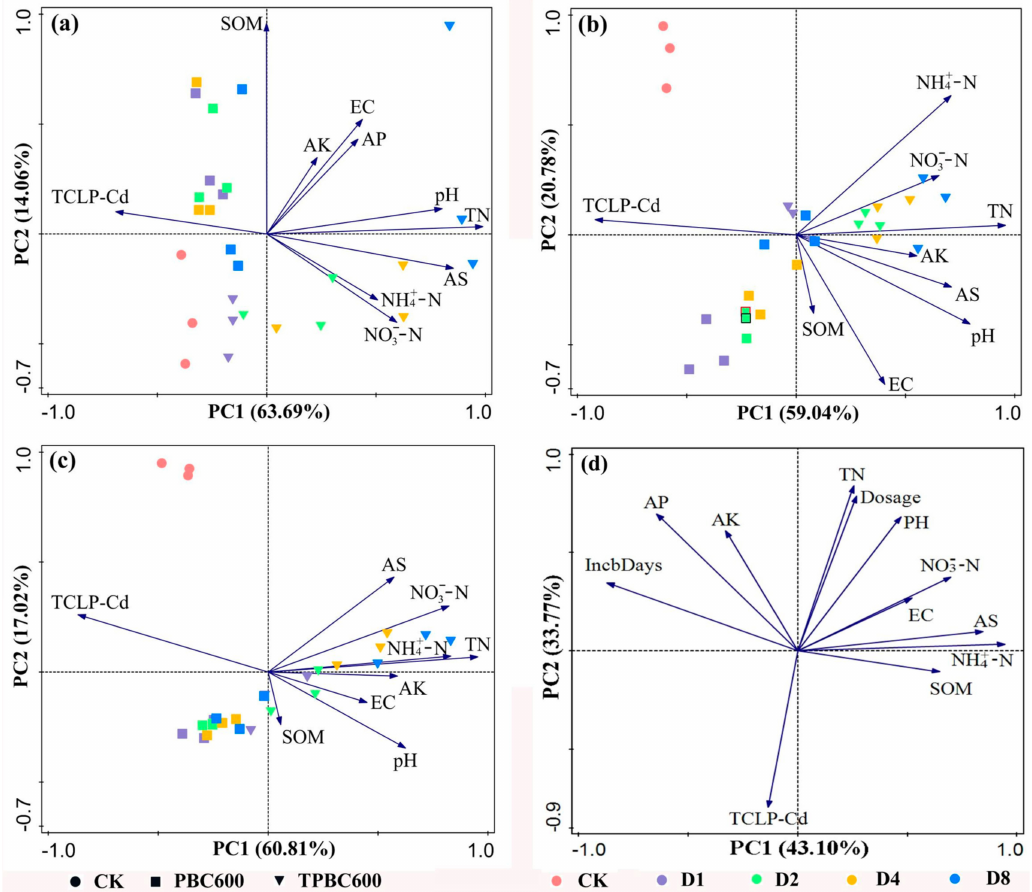
Figure 5. Principal component analysis results of the physical and chemical properties and available Cd content in soil. ( a ) Ten days of incubation, ( b ) 20 days of incubation, ( c ) 30 days of incubation, ( d ) physical and chemical properties of the soils, incubation time, biochar dosage, and available Cd content in the